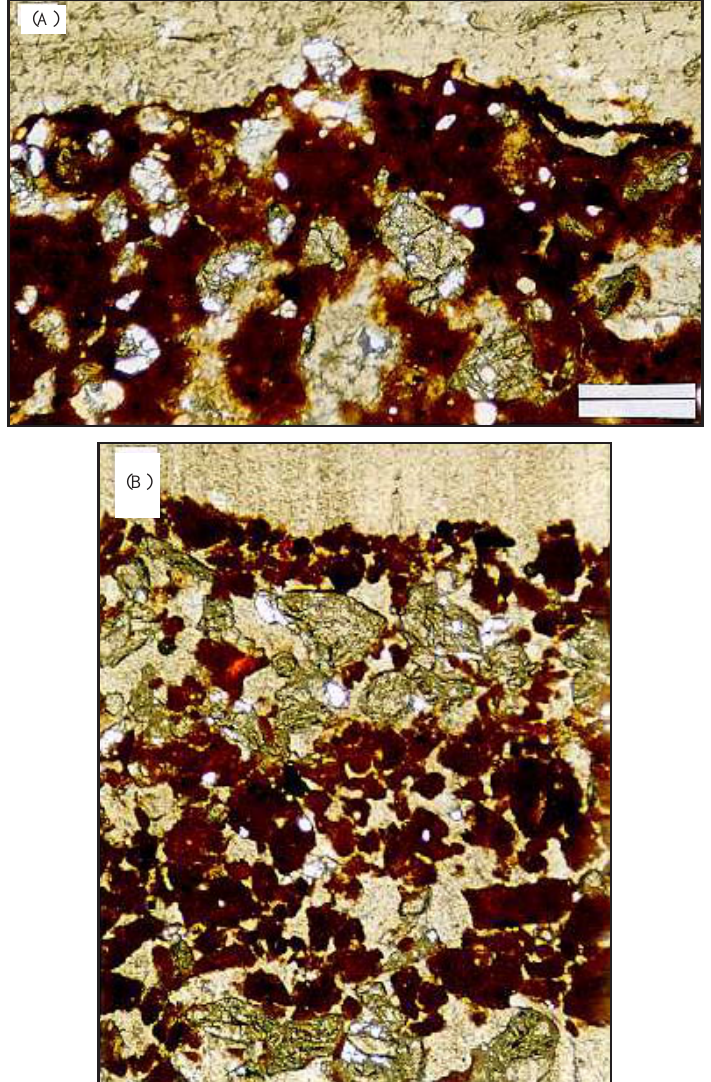
Figure 3. A: Micrograph of thin section of an aggregate at the top of the cut + herbicide cover, showing no traces of microerosion or physical disruption; and B: Micropedological effect of surface sealing of the hoe-weeded cover. Platy structural pattern with planar pores, formed by selective deposition of suspended particles. Note sorting and the presence of layers of quartz and broken aggregates (bar = 1